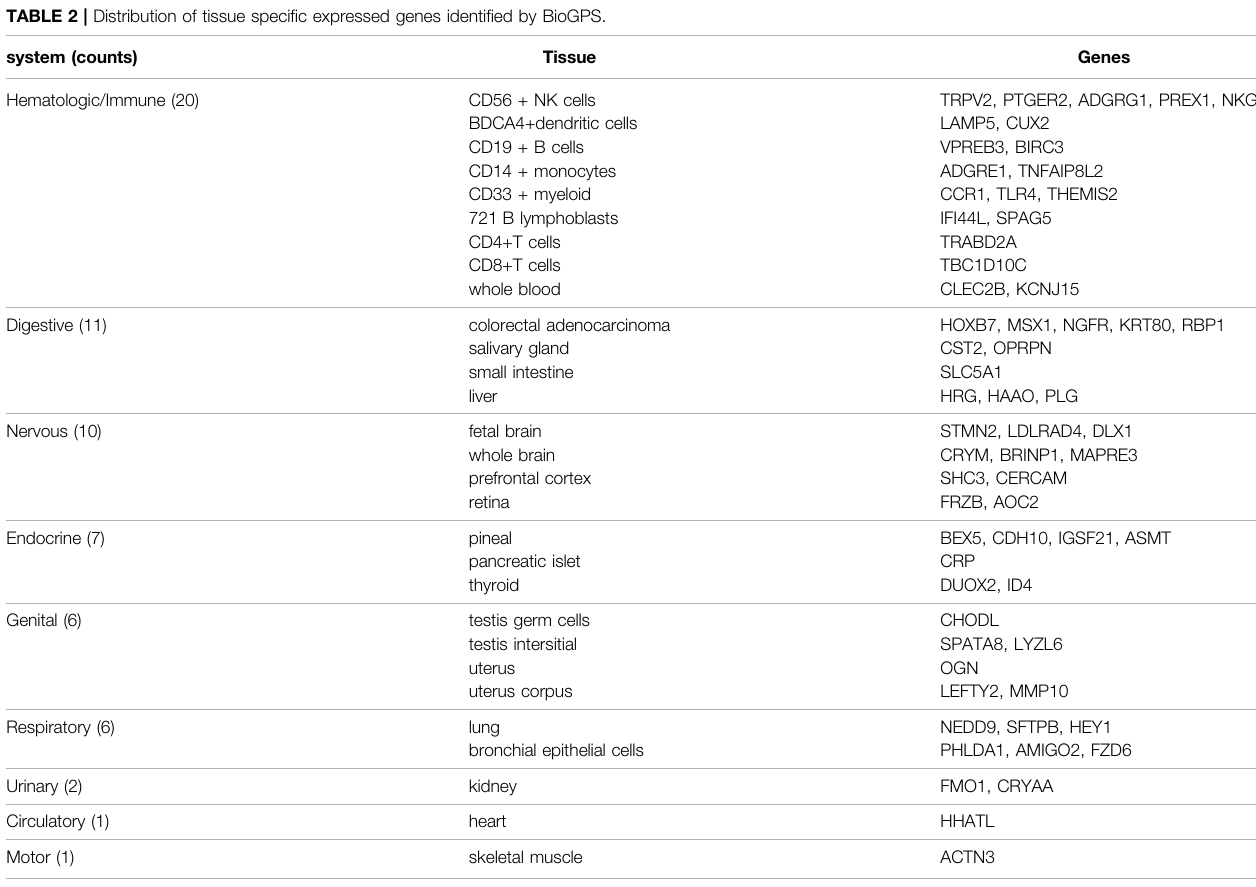
TABLE 2 | Distribution of tissue speci fi c expressed genes identi fi ed by